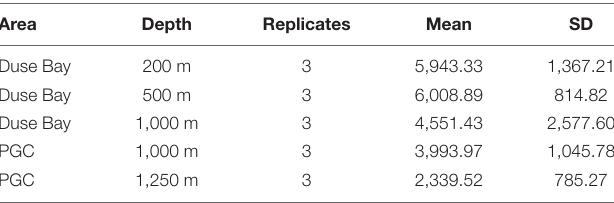
TABLE 3 | Number of individuals per 10 cm − 2 of the 0–2 cm layer showed as mean, followed by standard deviation (SD) values.